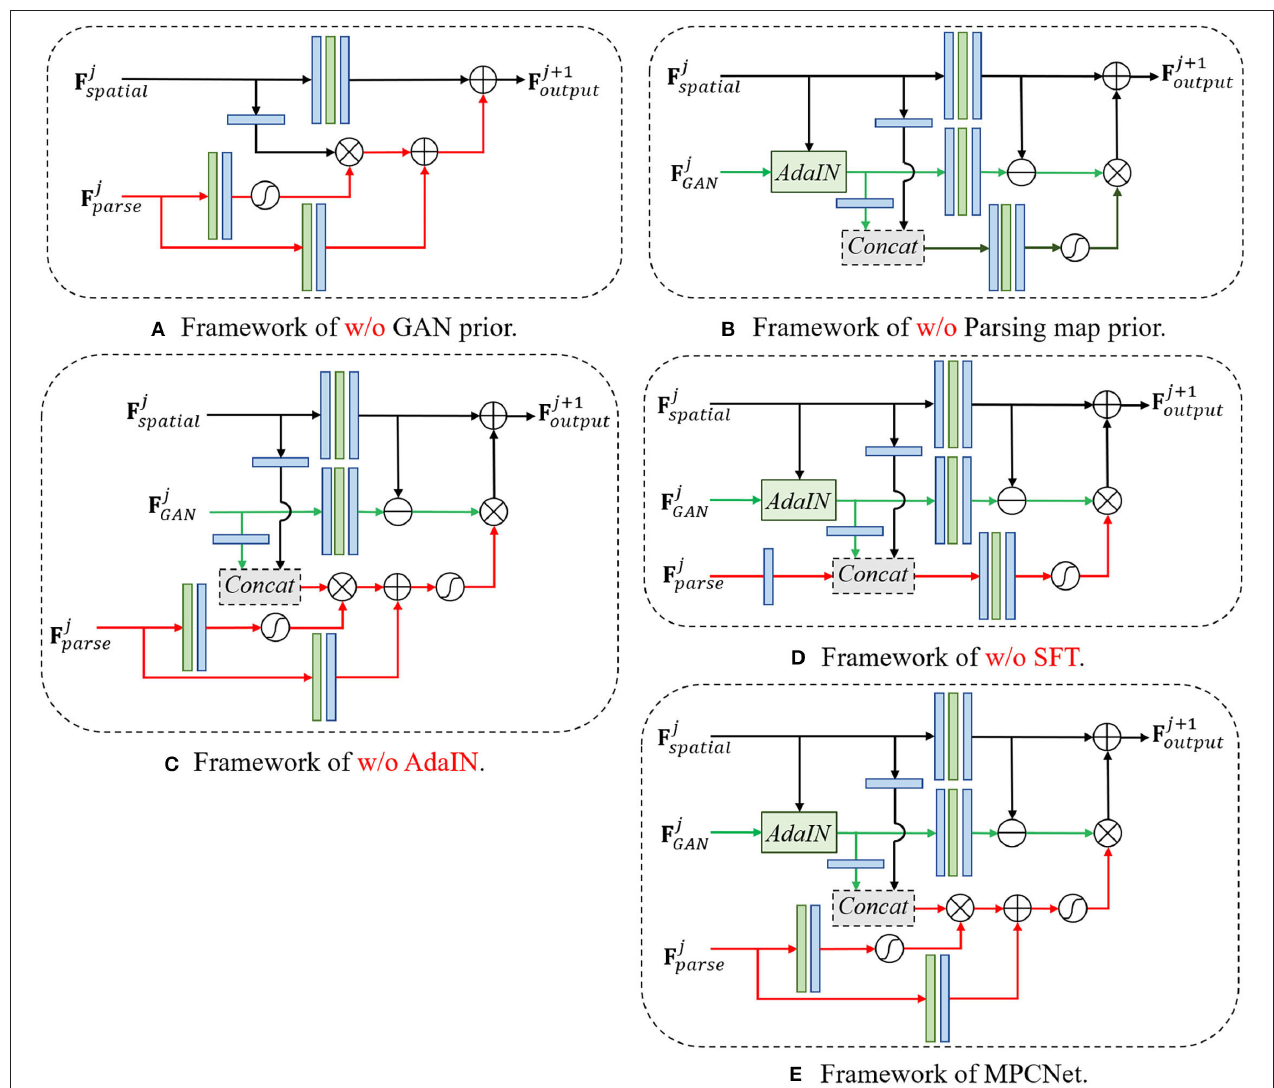
FIGURE 6 | Structure diagrams of different network versions used in the ablation study. (A) Framework of w/o GAN prior. (B) Framework of w/o parsing map prior. (C) Framework of w/o AdaIN. (D) Framework of w/o SFT. (E) Framework of w/o